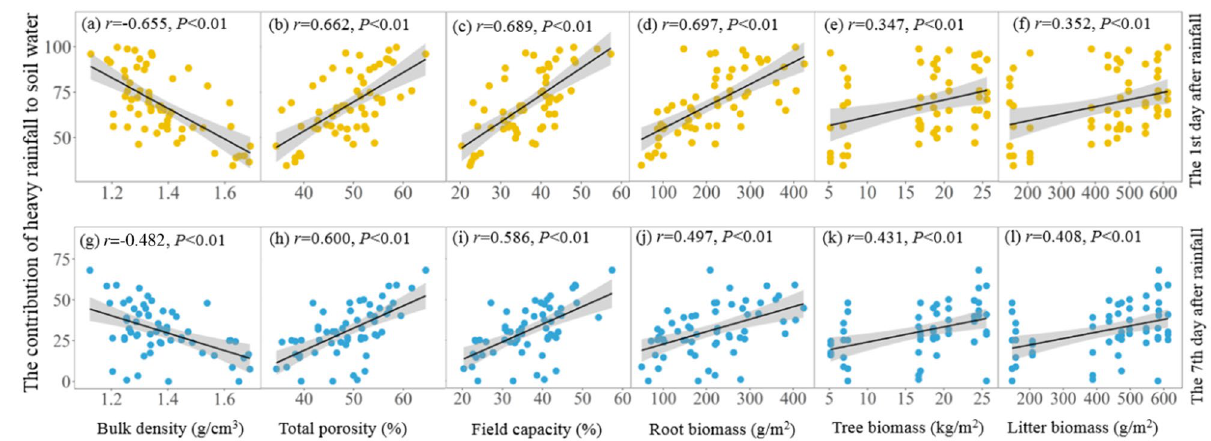
Figure 5. Relationships between the contributions of heavy rainfall to soil water and bulk density (a,g) , total porosity (b,h) , field capacity (c,i) , root biomass (d,j) , tree biomass (e,k) and litter biomass (f,l) on the first and seventh days after heavy CRSW. Root (Fig. 5d,j), tree (Fig. 5e,k) and litter biomass (Fig. 5f,l) were significantly positively correlated with the CRSW. This result indicates that both soil and vegetation factors could influence the CRSW under different forest management practices. Soil and vegetation factors were compared among the four stands (Tables 3 and 4). The tree biomass and litter biomass levels of the HIT stand were significantly lower than those of the other stands ( P < 0.05; Table 4). The litter biomass in the NTN and LIT stands was significantly higher than that in the USR stand, which included twice as much litter biomass as the HIT stand (Table 3). Similarly, root biomass levels in the HIT stand were lower than those in the NTN stand except at the 0–20 and 60–80 cm depths (Table 4). In addition, the HIT stand presented significantly lower total porosity and field capacity levels and higher bulk density values than the NTN stand (Table 4). Soil properties in the LIT stand did not differ from those in the NTN stand (Table 4).